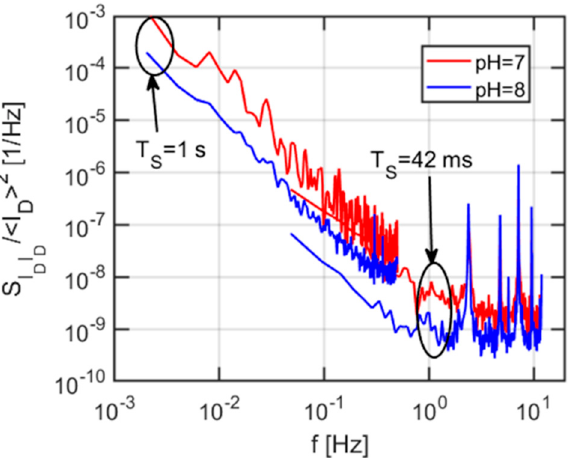
Figure 13. Normalized drain current noise PSD using two different pH buffers.